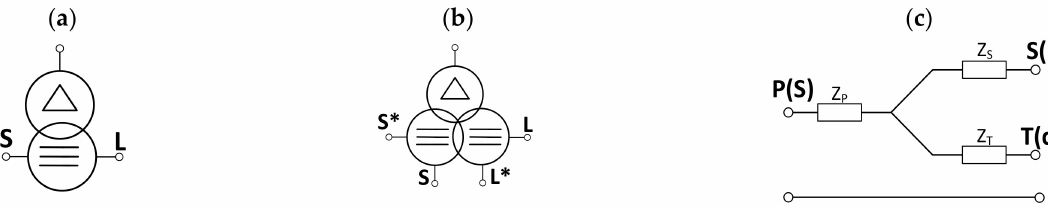
Figure 14. ( a ) Physical model of SU, ( b ) 3-winding transformer model used for SU representation and their ( c ) short circuit equivalent circuit (where * is a beginning of the